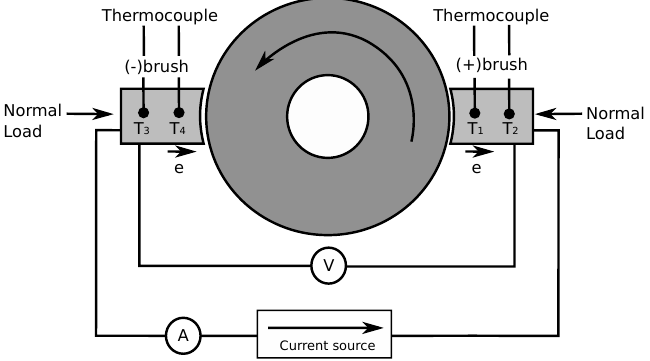
Figure 5. Outline of the wear test from an article by Shin W-G. and Lee S-H.